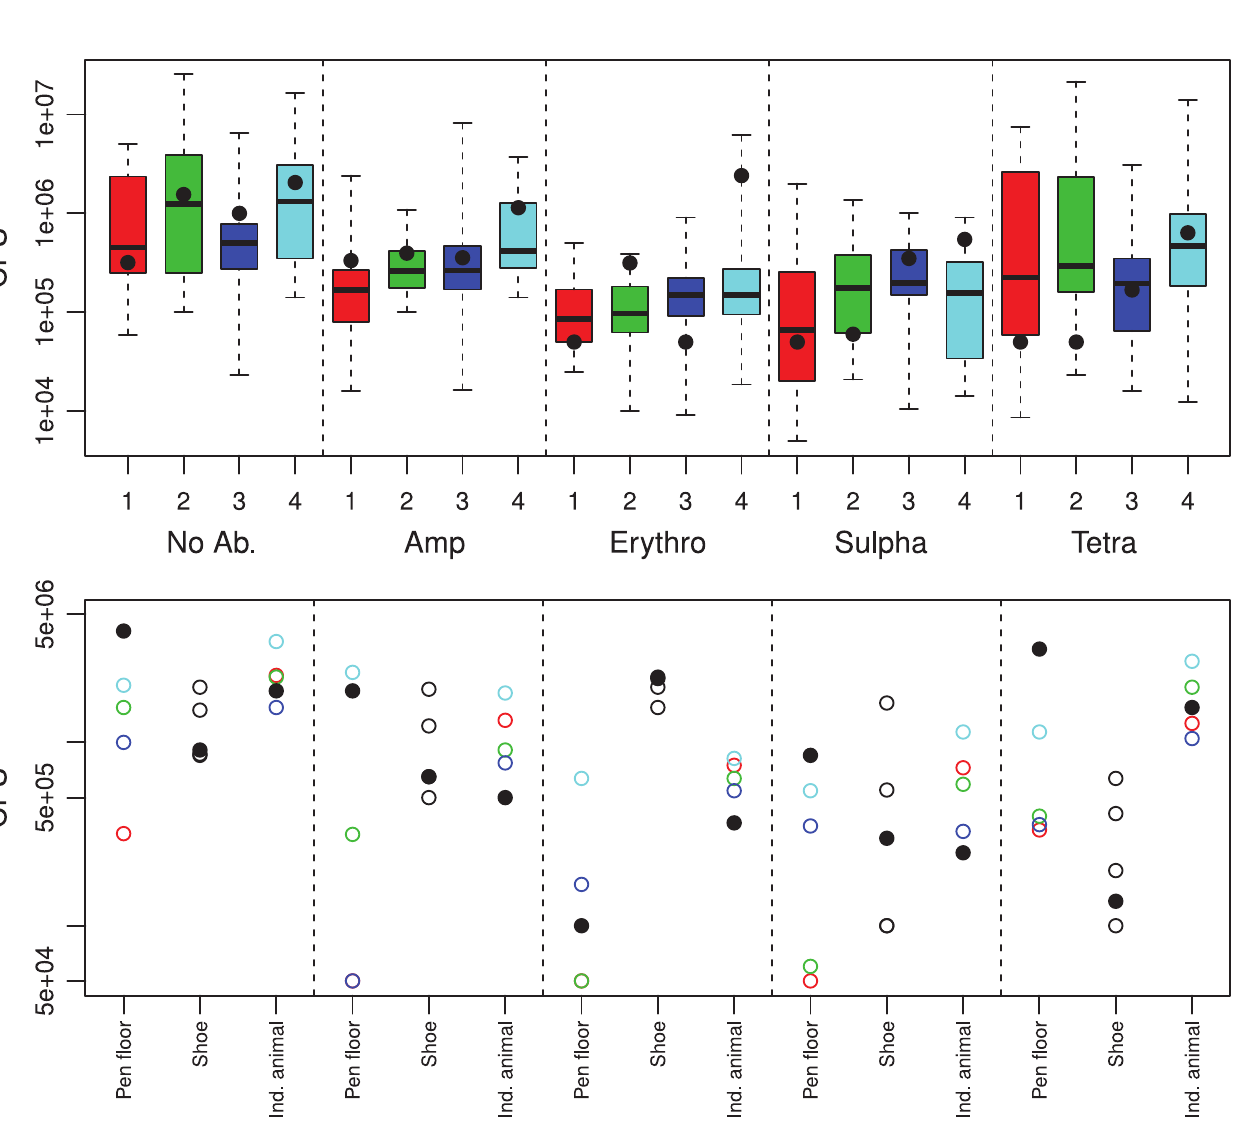
PLOS ONE | DOI:10.1371/journal.pone.0131672 June 26,